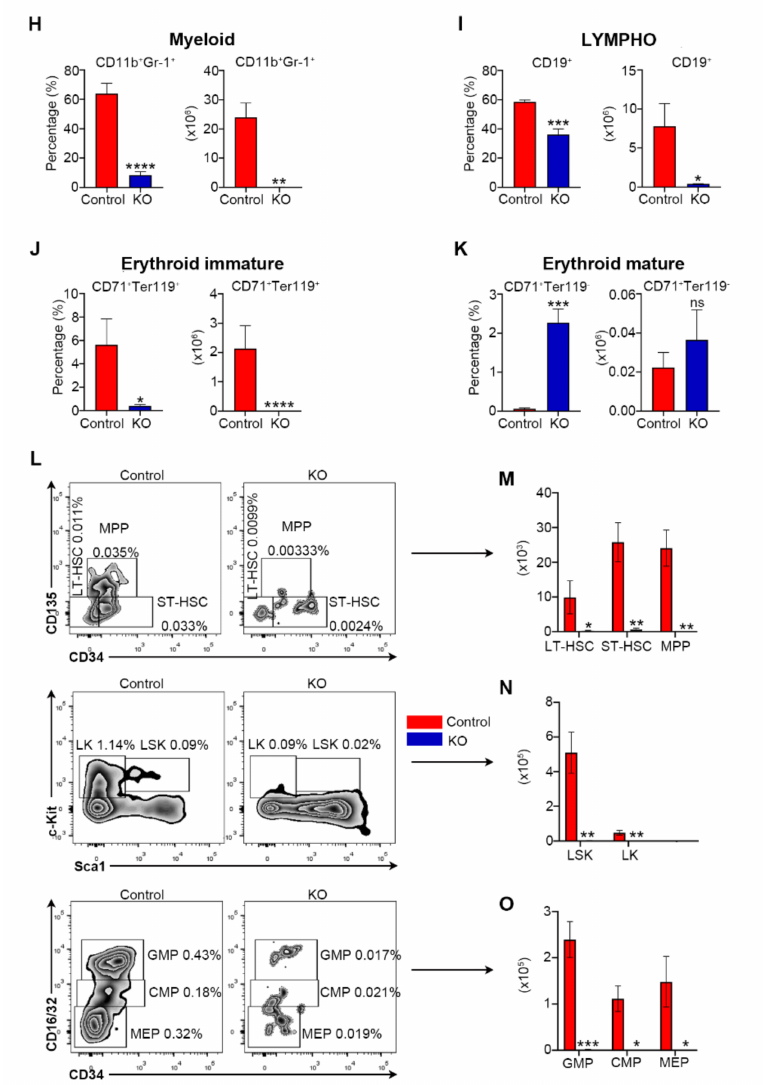
Figure 3. Myh9 function in hematopoiesis is cell autonomous. ( A ) Schematic diagram of bone marrow transplantation strategy. 1 × 10 6 BM cells were harvested from uninduced Myh9 fl/fl :Mx1-cre and control mice and transplanted into lethally irradiated wild type C57BL/6 recipient mice. Six weeks after bone marrow transplantation, three doses of poly I:C were injected to induce the deletion of Myh9 in donor-derived hematopoietic cells. Mice were analyzed 12 days after first poly I:C injection. ( B ) Real time PCR analysis showed deletion of Myh9 in the BM of Myh9 fl/fl :Mx1-cre recipient mice after induction of poly I:C (n = 3). ( C ) BM cellularity was significantly reduced in Myh9 fl/fl :Mx1-cre recipient mice compared with control mice 12 days after poly I:C injection (n = 4). ( D ) Peripheral blood counts were assessed at 12 days after poly I:C induction in control and Myh9 fl/fl :Mx1-cre BMT mice (n = 4). Representative dot plots ( E , F , G ), frequencies, and total numbers of Gr-1 + CD11b + myeloid ( H ), CD19 + B cells ( I ), CD71 + Ter119 - immature erythroid cells ( J ), and CD71 - Ter119 + mature erythroid cells ( K ) (n = 4–5). ( L ) Representative contour plots of flow cytometric analysis of LK, LSK, LT-HSC, ST-HSC, MPP, GMP, CMP, MEP. Total numbers of LK and LSK ( M ); LT-HSC, ST-HSC and MPP ( N ); GMP, CMP, and MEP ( O ) in the BM of control and Myh9 fl/fl :Mx1-cre BMT mice 12 days after poly I:C injection (n = 4). All data are shown in bar graphs as mean ± SD. Student t test was used to compare two groups of mice (* p < 0.05,** p < 0.005,*** p < 0.001,**** p <